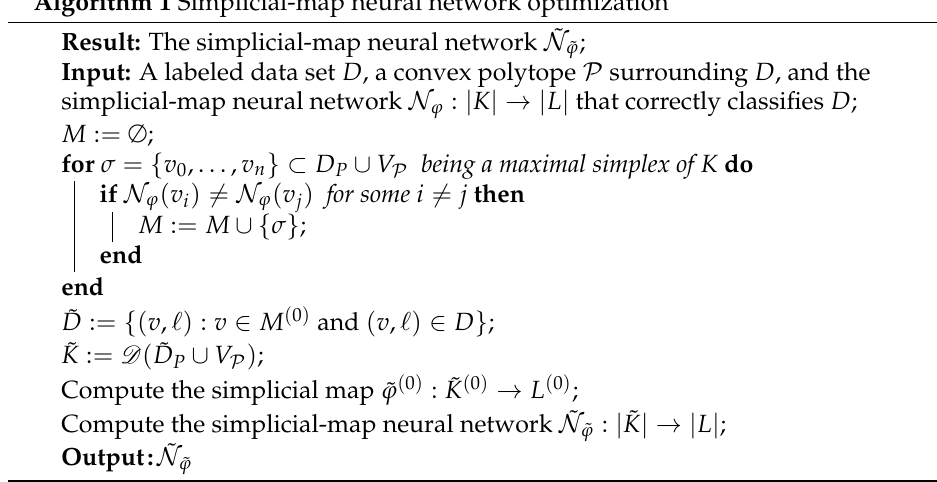
Algorithm 1 Simplicial-map neural network